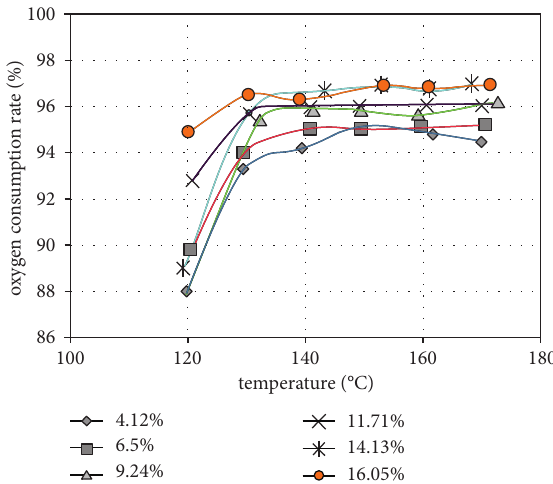
Figure 17: Evolution of CO concentration, as an index of coal spontaneous combustion, for samples with different moisture content in the temperature range of 120–170 °